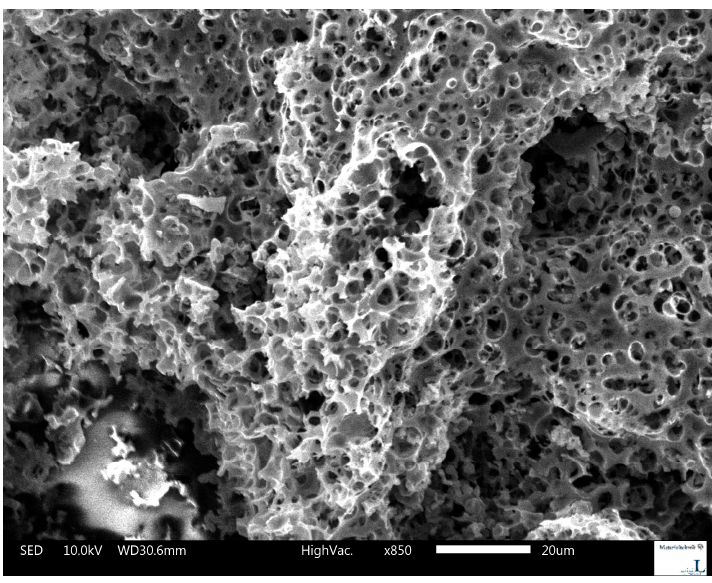
Figure 2. SEM image of activated carbon prepared from olive stones. The scale bar stands for 20 µm.